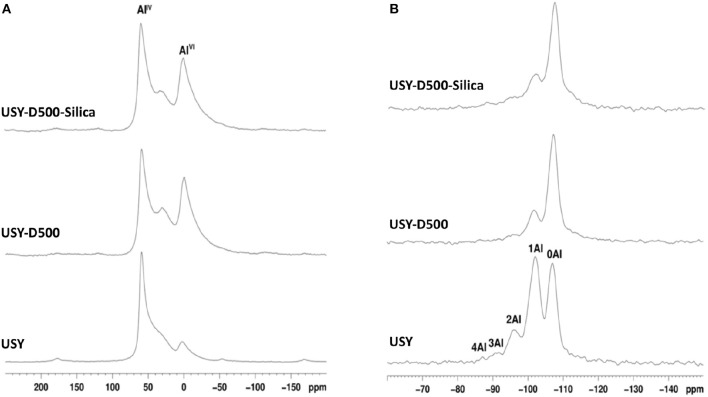
MAS-NMR spectra obtained for the catalysts studied. (A)
27Al MAS-NMR; (B)
29Si MAS-NMR (the areas of 27Al MAS-NMR signals are listed in Table S2, whereas the areas of 29Si MAS-NMR signals are listed in Table S3).